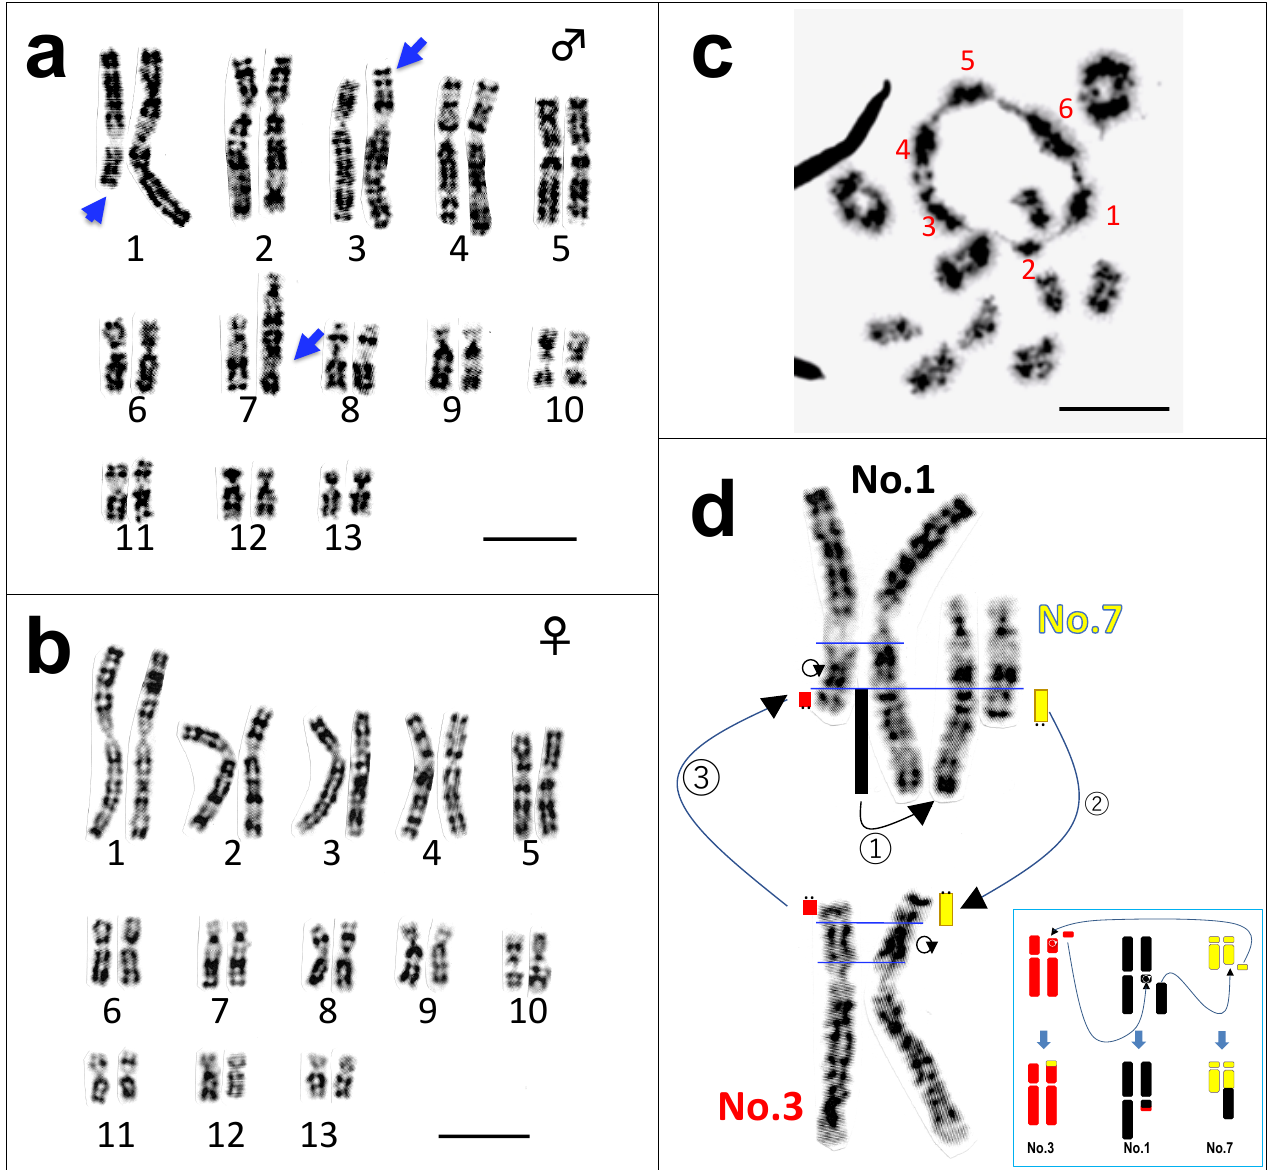
Figure 1. Somatic and meiotic chromosomes of Odorrana swinhoana . Late replication banded karyotypes in male ( a ) and female ( b ). Chromosomes 1, 3, and 7 are heteromorphic in males (indicated by arrows), whereas they are homomorphic in females. The metaphase at first meiotic division comprises one hexavalent and ten bivalent rings ( c ). Each of the chromosome members comprising the hexavalent is numbered in red. The presumed pathway of triangular translocations through the chromosomes 1, 3 and 7 in male ( d ). The translocated chromosomal parts are diagrammatically indicated in black (chromosome 1), red (chromosome 3) and yellow (chromosome 7). The three translocations are diagrammatically represented in a box at the right bottom. Telomeres are indicated by two dots. The ring with an arrowhead indicates an inversion. Bar, 10 µ